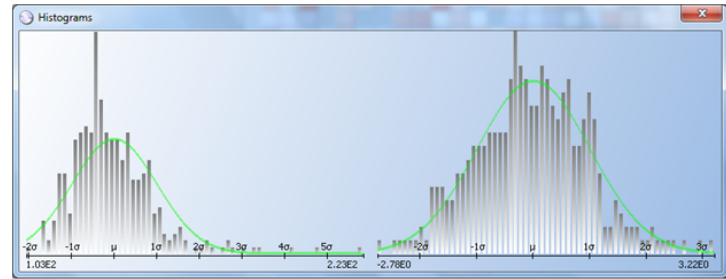
Figure 11. Log-normal to normal distribution transformation.